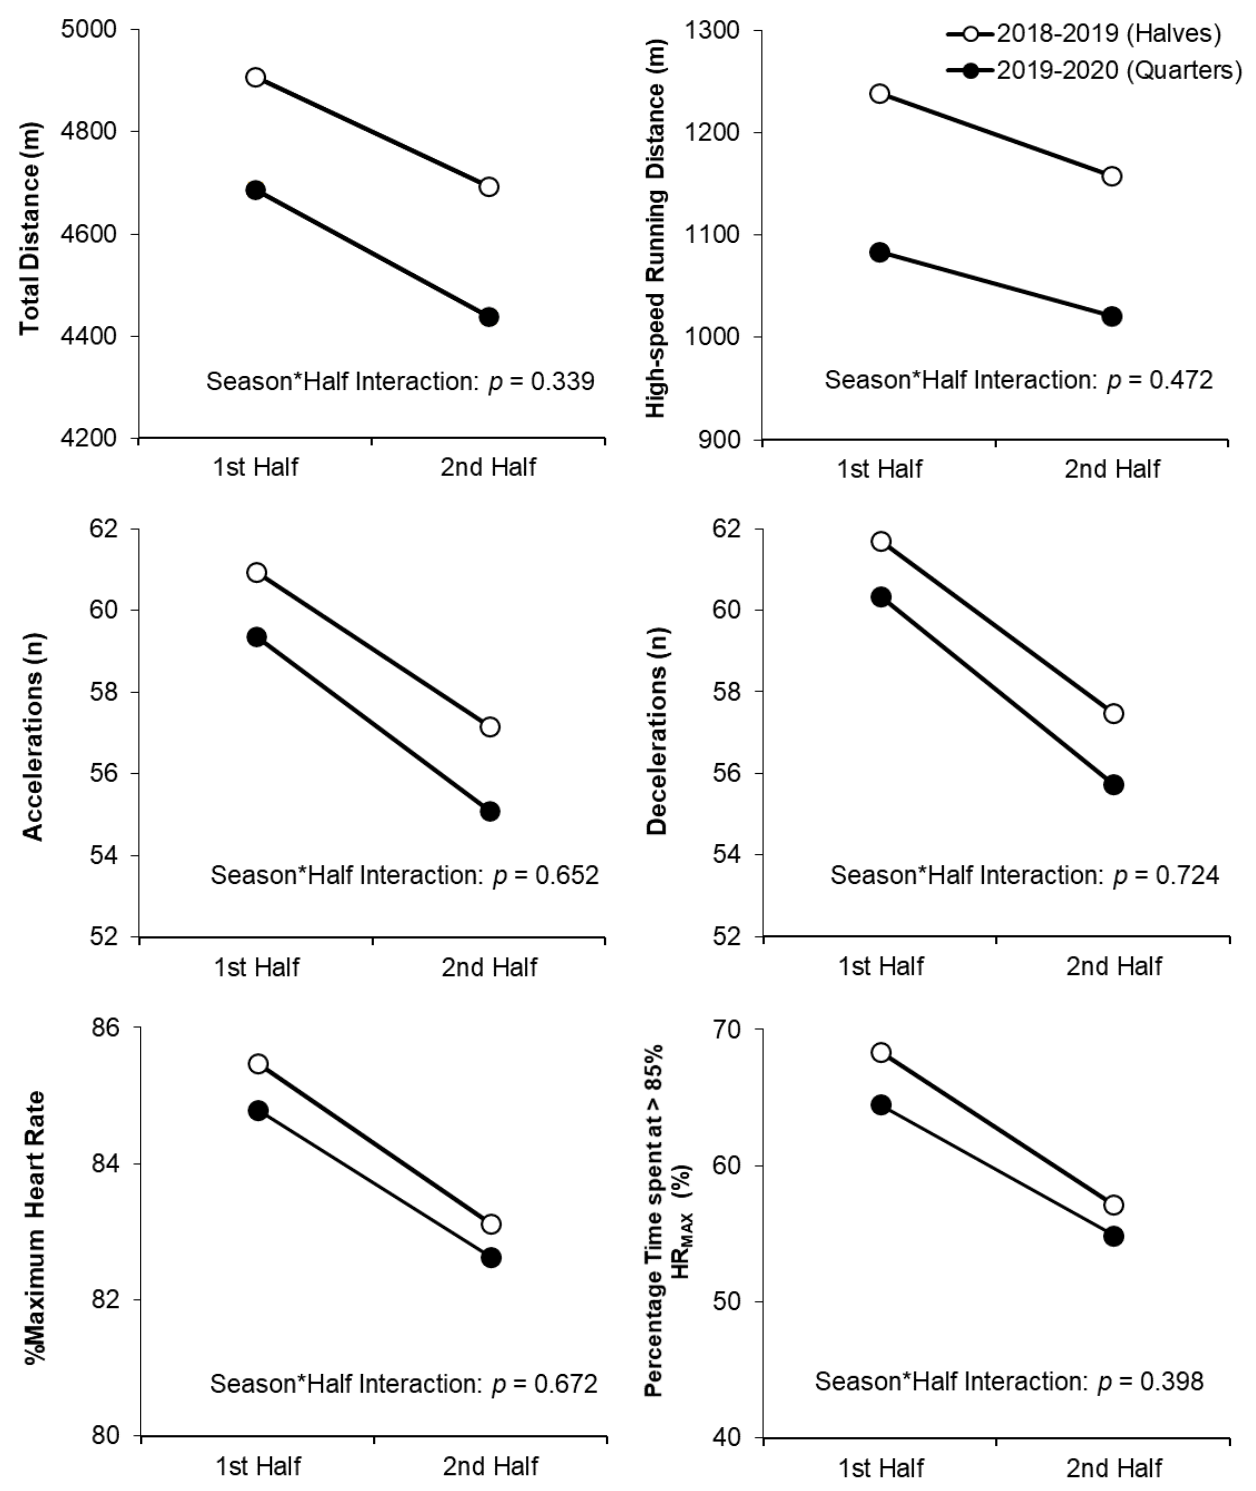
Figure 1. Mean values obtained from multilevel models of 1st and 2nd half match play data, from matches where the playing format was 2 × 35 min halves (2018–2019 season) or 2 × 2 × 17.5 min quarters (2019–2020 season). Dependent variables were normalised by extrapolating values to the full half playing time of 35 min. Percentage of time spent at >85% HR MAX = percentage (%) of total time spent at a zone exceeding 85% of maximum heart rate. There were no cross-level interaction effects observed between season and half for the dependent variables studied ( p > 0.05).